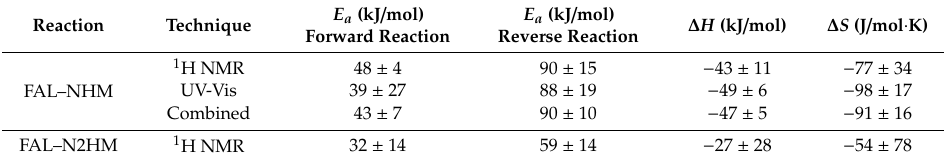
Table 3. Activation energy, enthalpy, and entropy of formation by reaction and technique.